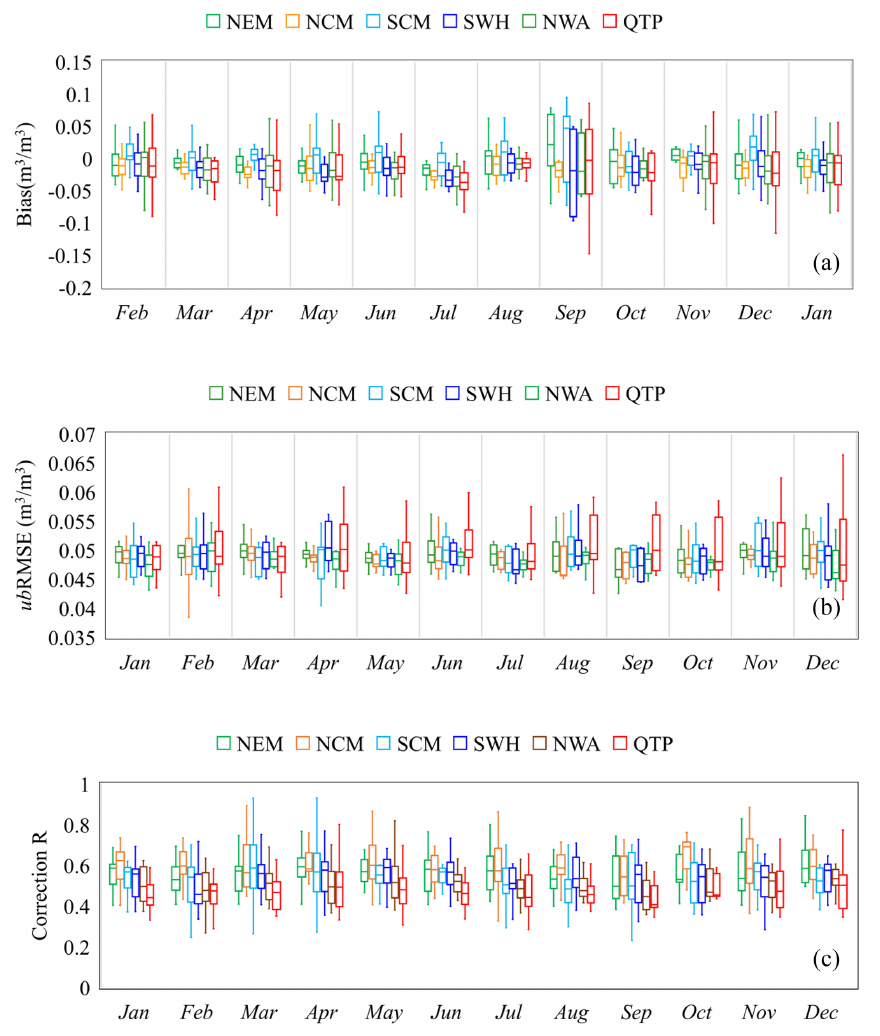
Figure 4. Box plots of the RMSE, bias and R ( p < 0 . 05) of comparison between downscaled SM and in situ SM in each